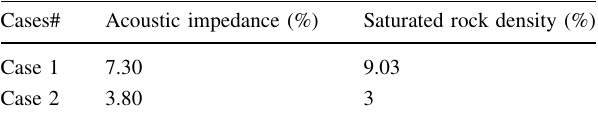
Table 8 Change in percent in AI and q s Cases#